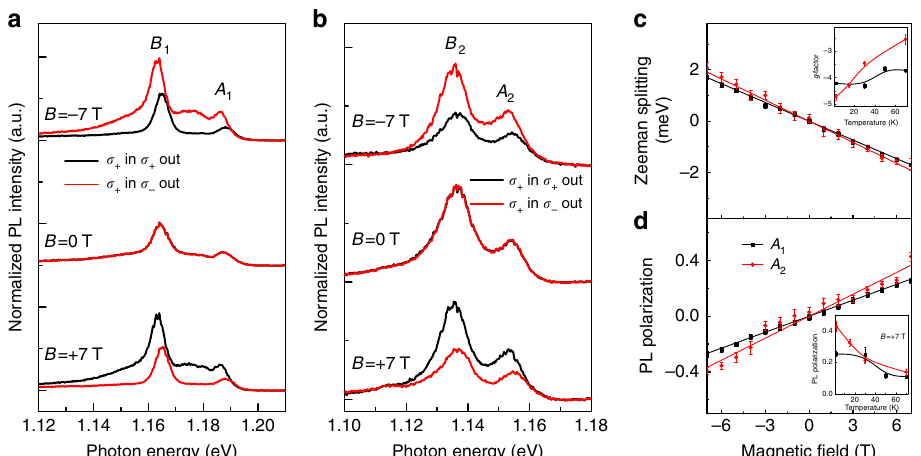
Fig. 2 Zeeman splitting and PL polarization in bilayer MoTe 2 . a , b Off-resonant polarization-resolved PL spectra taken at − 7, 0, and +7 T at 2 K with an excitation energy of 1.560 eV (795 nm) in monolayer MoTe 2 ( a ) for reference and bilayer MoTe 2 ( b ). The excitation is set to σ + circular polarization. The detection polarization is con fi gured to σ + (black solid lines) and σ − (red solid lines) circular polarization. The PL intensity of the bilayer is one order of magnitude smaller than that in the monolayer due to higher symmetry of the bilayer. Here the PL spectra is normalized by emission maximum for each particular magnetic fi eld and offset for better visualization. c , d The Zeeman splitting ( c ) and PL polarization ( d ) of the neutral exciton (peak A 2 ) in bilayer MoTe 2 (red symbols and lines) vs. magnetic fi eld at 2 K. The inset shows the PL polarization at different temperature at +7 T. The black symbols and lines are results of the monolayer (peak A 1 ) for reference. The error bars are calculated from Lorentzian fi t of the spectral